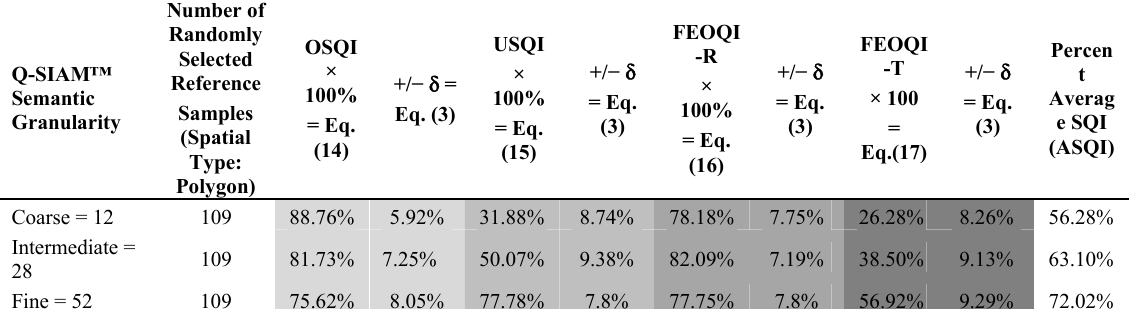
Table 18. Mean of the sum over all values of a local SQI estimator = Equation (14) to Equation (17) ±δ = Equation (3), where the mapped sub-symbolic image-objects are identified via Equation (12) from the reference segments of class buildings . Mapped image-objects belong to the three-scale segmentation map automatically generated from the SIAM™ three-granule pre-classification map of the Leica test image, with α = 0.05, 1 − α = 0.95, χ 2 = 3.84 in Equation